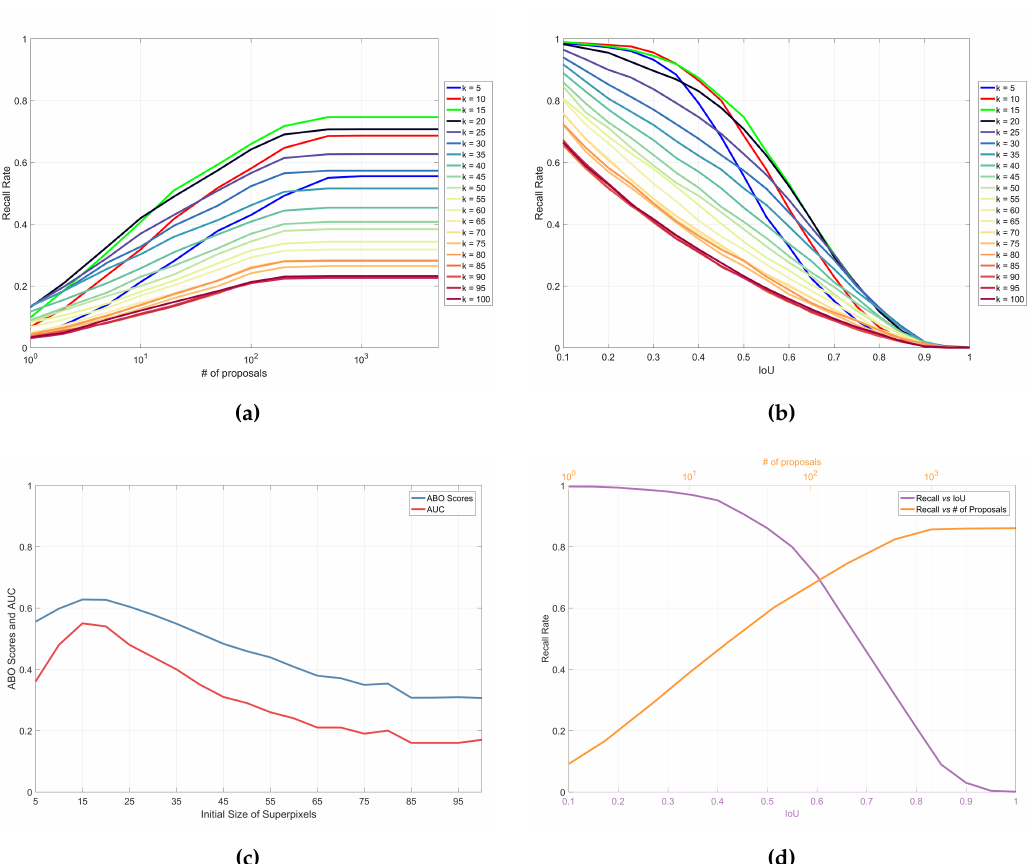
Figure 5. The recall under different initial superpixel size. ( a ) the curves measuring the recall versus numbers of ship proposals under different k ; ( b ) the curves measuring the recall versus the intersection over union (IoU) under different k ; ( c ) the average best overlap (ABO) scores and the area under the curve (AUC) versus different k ; ( d ) The recall using k = 15 and k =